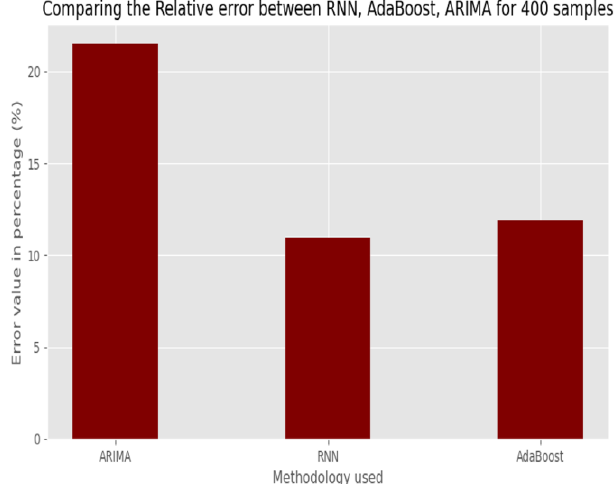
Figure 18. Comparing the Relative error between RNN, AdaBoost, ARIMA for 400